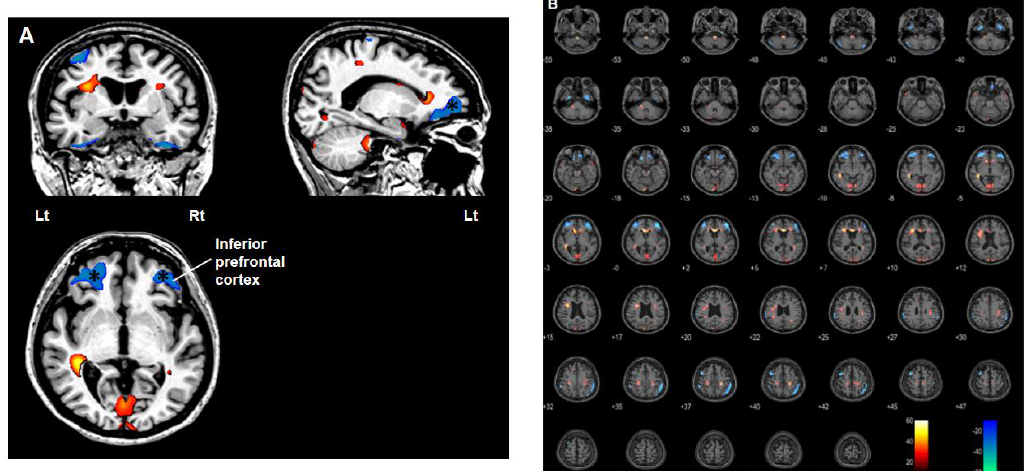
Figure 7. PET / MRI co-registration and voxel-based subtraction analysis of three years after deep brain stimulation (DBS) from pre-operation. Red scale indicates an increase in glucose metabolism and blue scale indicates a decrease in glucose metabolism. ( A ) A noticeable decrease in glucose metabolism in the orbitoprefrontal and inferior prefrontal cortex (asterisk). ( B ) A bilateral decrease in glucose metabolism was observed in the cerebellum, inferior temporal lobe, sensory cortex, superior parietal cortex and, especially orbito-, and inferior prefrontal cortex and an increase in glucose metabolism was identified in the medulla, pons, midbrain, occipital cortex including cuneus and calcarine sulcus, motor cortex mainly for leg and feet, anterior part of the insula, anterior cingulate cortex and genu of corpus callosum on the PET / MRI images obtained three years after DBS. Table 2. The values given are the stereotactic MNI coordinates and the peak value of each anatomical region. The threshold was set at 2 standard deviations of SISCOM results. (Voxel size: [2.0, 2.0, 2.0] mm, Minimum cluster size threshold of 50 voxels.).